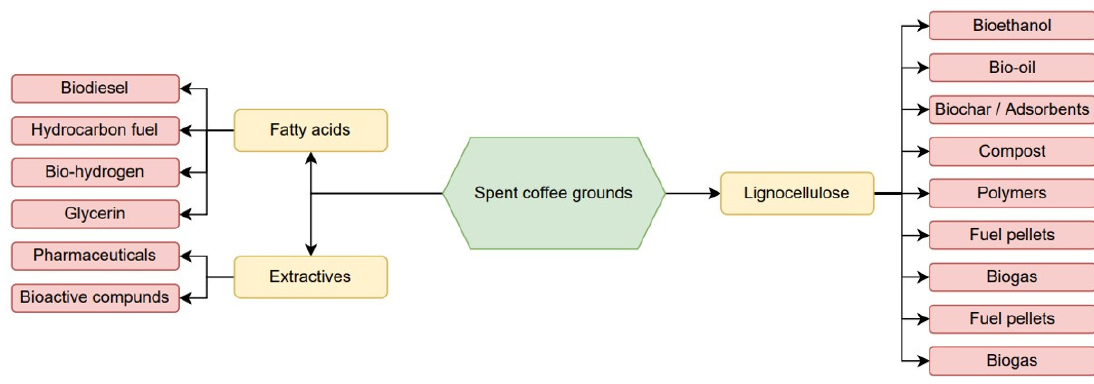
Figure 1. Biorefinery concept of SCG.